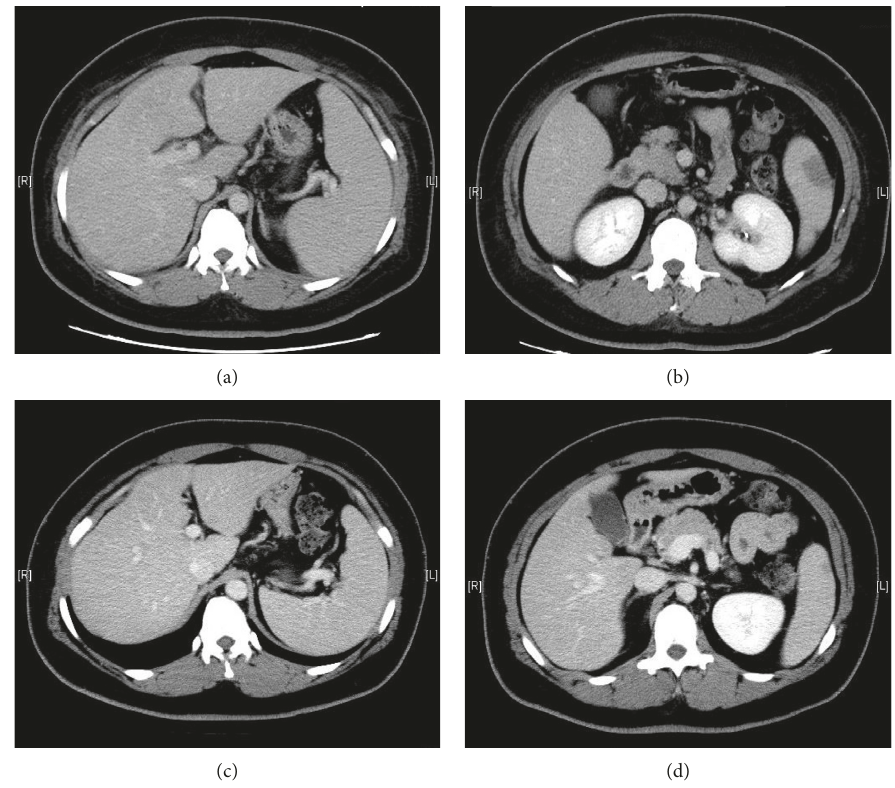
Figure 1: Abdominal computed tomography at admission. (a) Enlarged liver and spleen are shown. (b) A geographical low attenuation area is observed on the dorsal side of the spleen, which suggests splenic infarction. These findings were improved after ganciclovir treatment. (c) Enlarged liver and splenomegaly were improved. (d) The geographic low attenuation area in the spleen was